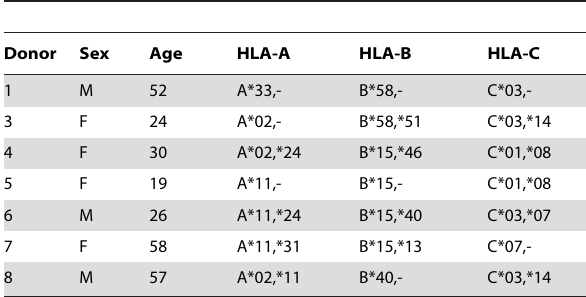
Table 1. Overview of sequence-based HLA-Ityping of the donors